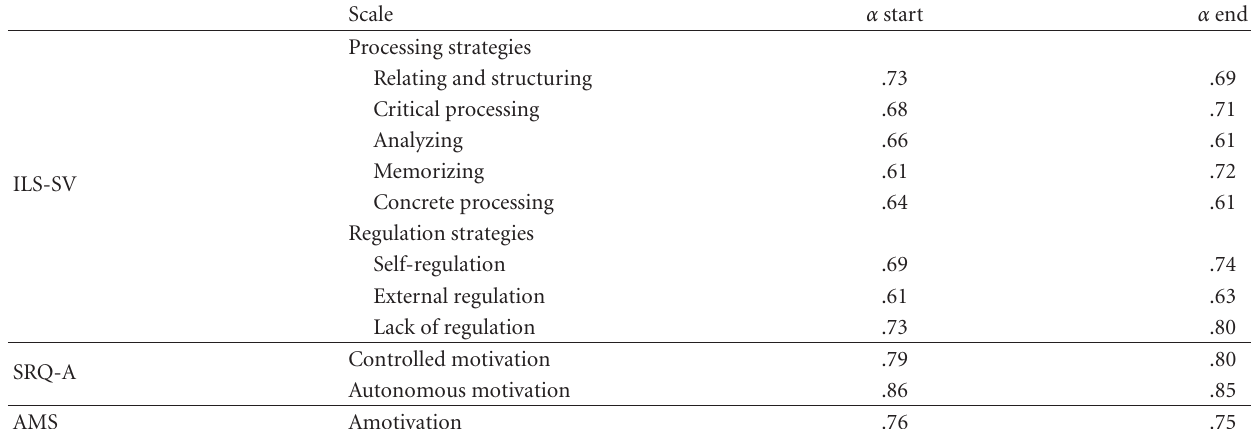
Table 4: Reliabilities for scales pertaining to the ILS-SV, SRQ-A, and